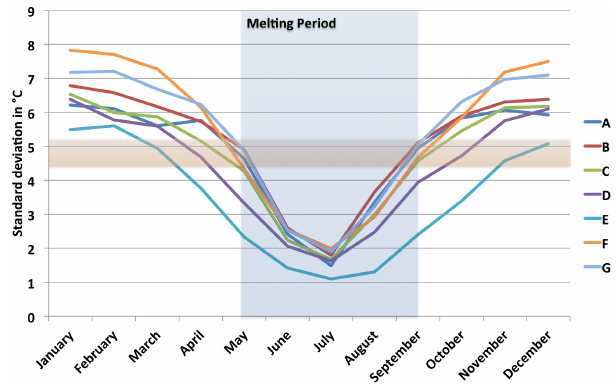
Fig. 2. Monthly SD values derived from ERA-40 temperature time series (1958–2001) and averaged over major drainage basins A to G (see Fig. 1 for area locations). The horizontal shaded area out- lines the range of commonly used uniform SD values. The verti- cal shaded area shows a typical period of ice/snow surface melt in Greenland (Rennermalm et al.,